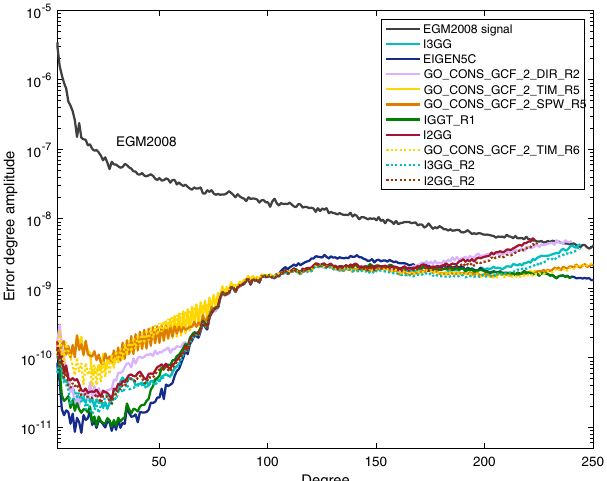
Figure 1. Difference degree amplitudes of the gravity field models DIR_R2, TIM_R5, SPW_R5, EIGEN-5C, IGGT_R1, I3GG, I2GG, TIM_R6, I3GG_R6, I2GG_R6 compared to